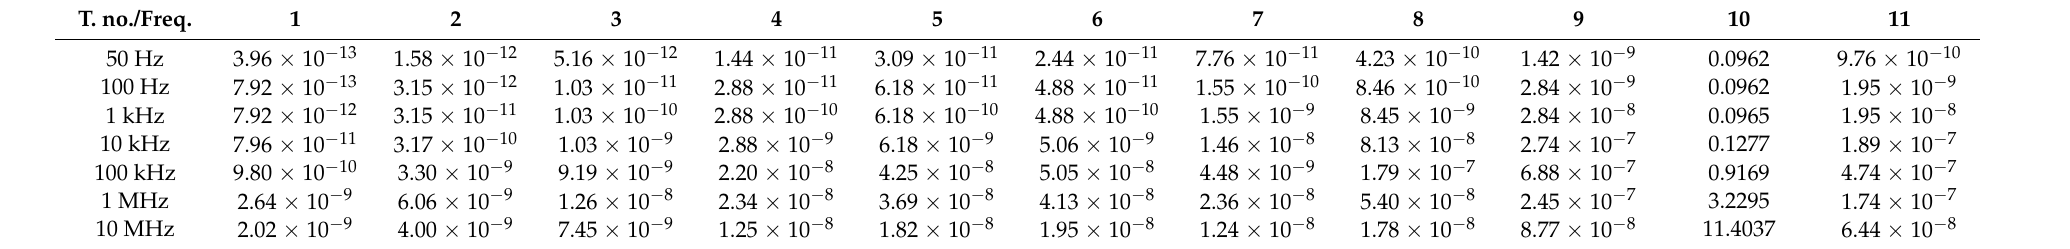
Table A19. Self and mutual resistances of turn 10 (in Ω ) resulting from FEM simulations. T. no./Freq.